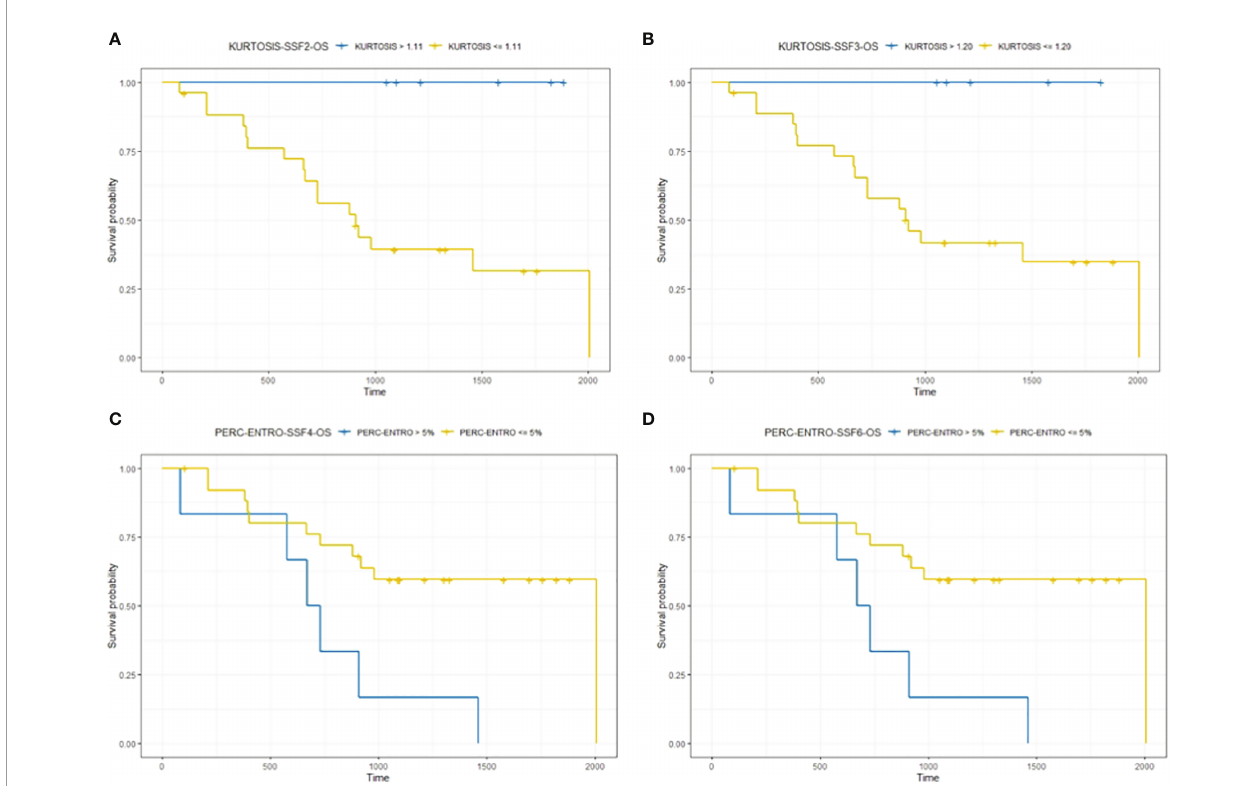
FIGURE 3 | The fi gure compares survival curve for baseline CT texture parameter kurtosis at fi ne (SSF = 2) and medium (SSF = 3) texture scales and delta-analysis quanti fi ed Perc-ENTRO at medium (SSF = 4) and coarse (SSF = 6) scales for OS. Patients in the good prognostic group, as identi fi ed by baseline kurtosis are fi ne (SSF = 2) and medium (SSF = 3) texture scales, had an improved median survival of around 17 (A) and 10 months (B) respectively, compared to the poor prognostic group. Furthermore, the good prognostic group, which was de fi ned using Kurtosis, demonstrated zero mortality. Patients in the good prognostic group, as identi fi ed by Perc-ENTRO at medium and coarse scales, improved median survival by around 11 months (C, D) compared to the poor prognostic group.